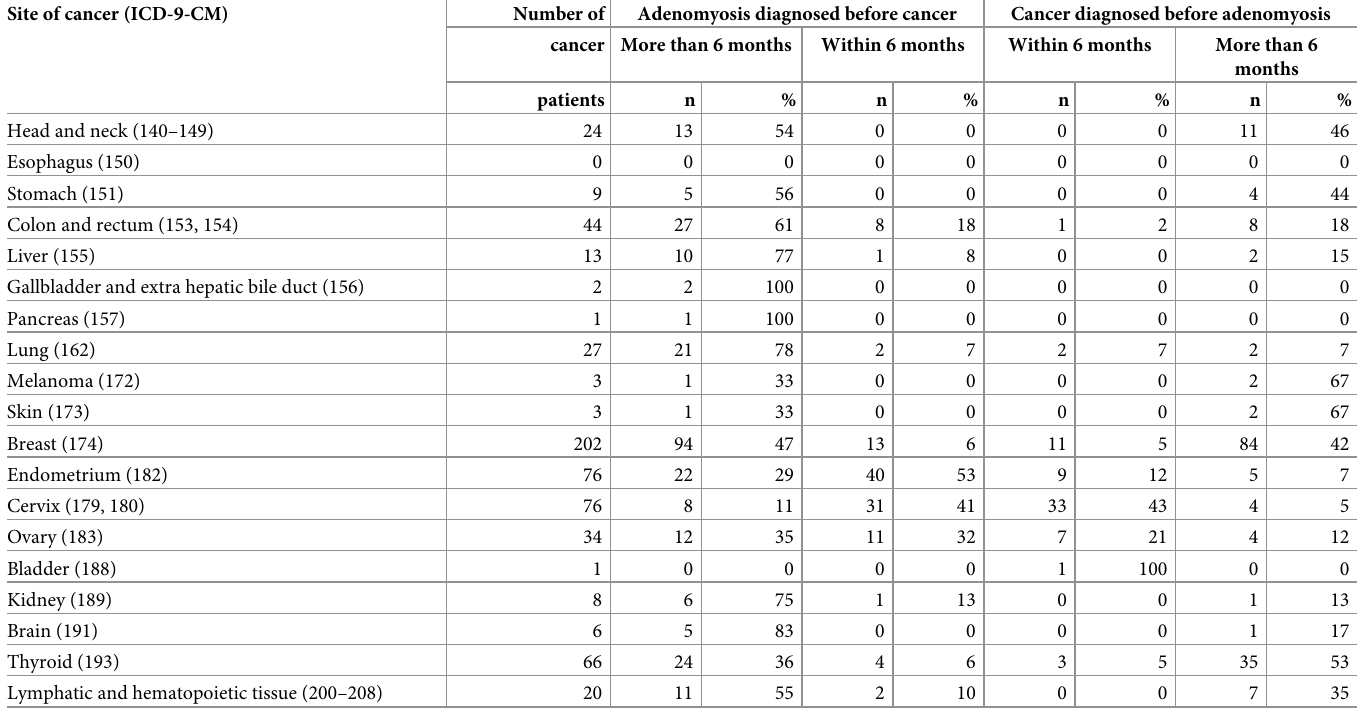
Table 1. Distribution of cancer types in the adenomyosis